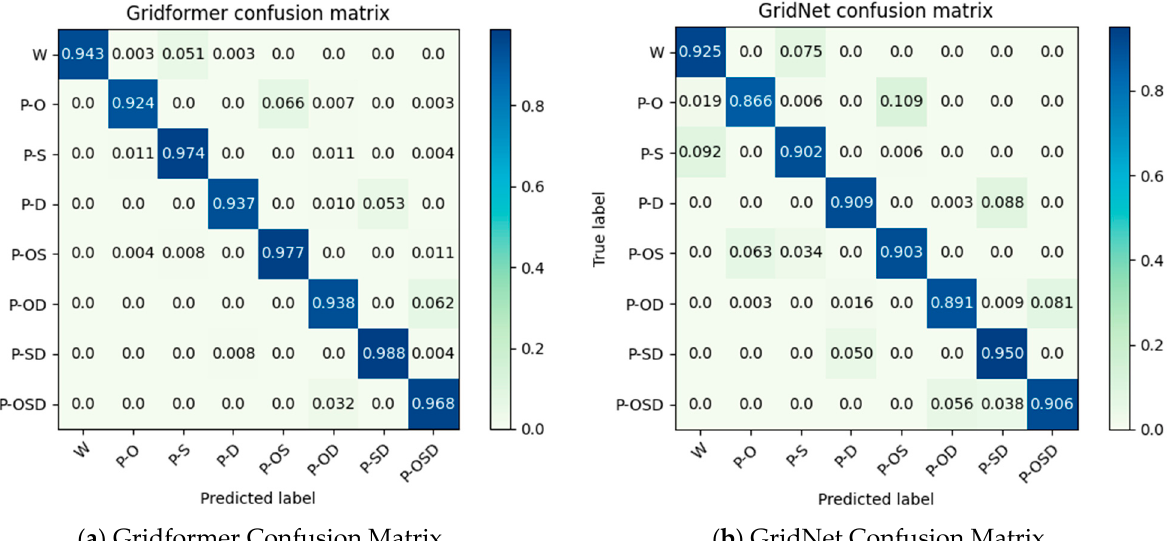
Figure 12. Gridformer Confusion Matrix vs. GridNet Confusion Matrix.